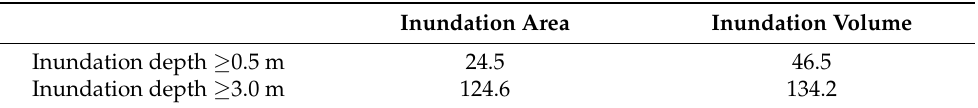
Figure 6. Inundation area averaged for the top 20 rainfall events (historical simulation) and top 36 rainfall events (future simulation) with ( a ) inundation depth ≥ 0.5 m, and ( b ) inundation depth ≥ 3.0 m. Table 3. Percentage difference of the mean values of the inundation area and inundation volume for inundation depths of ≥ 0.5 and ≥ 3.0 m between the top 20 rainfall events (historical simulation) and top 36 rainfall events (future